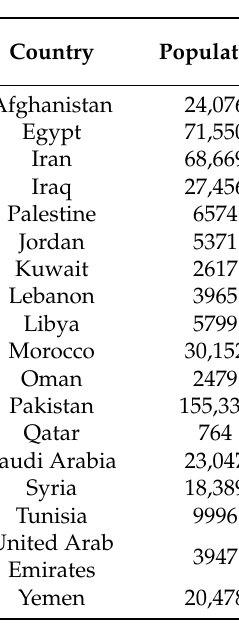
Table 2. Annual PM10 concentrations, deaths, and disability-adjusted life years (DALYs) in MENA countries, according to Ostro